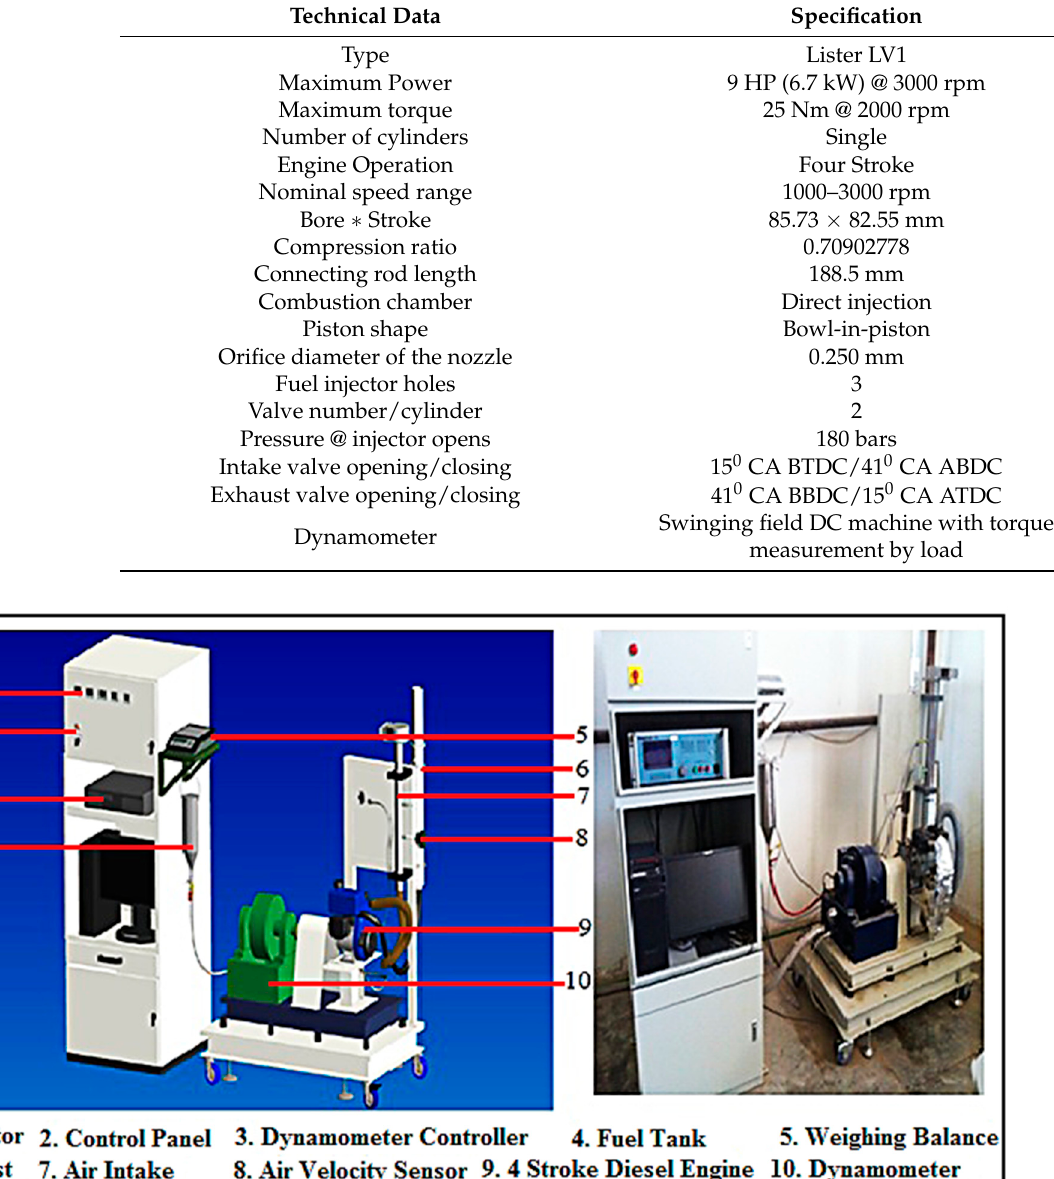
Table 1. Technical data of PETTER PHIW diesel engine.